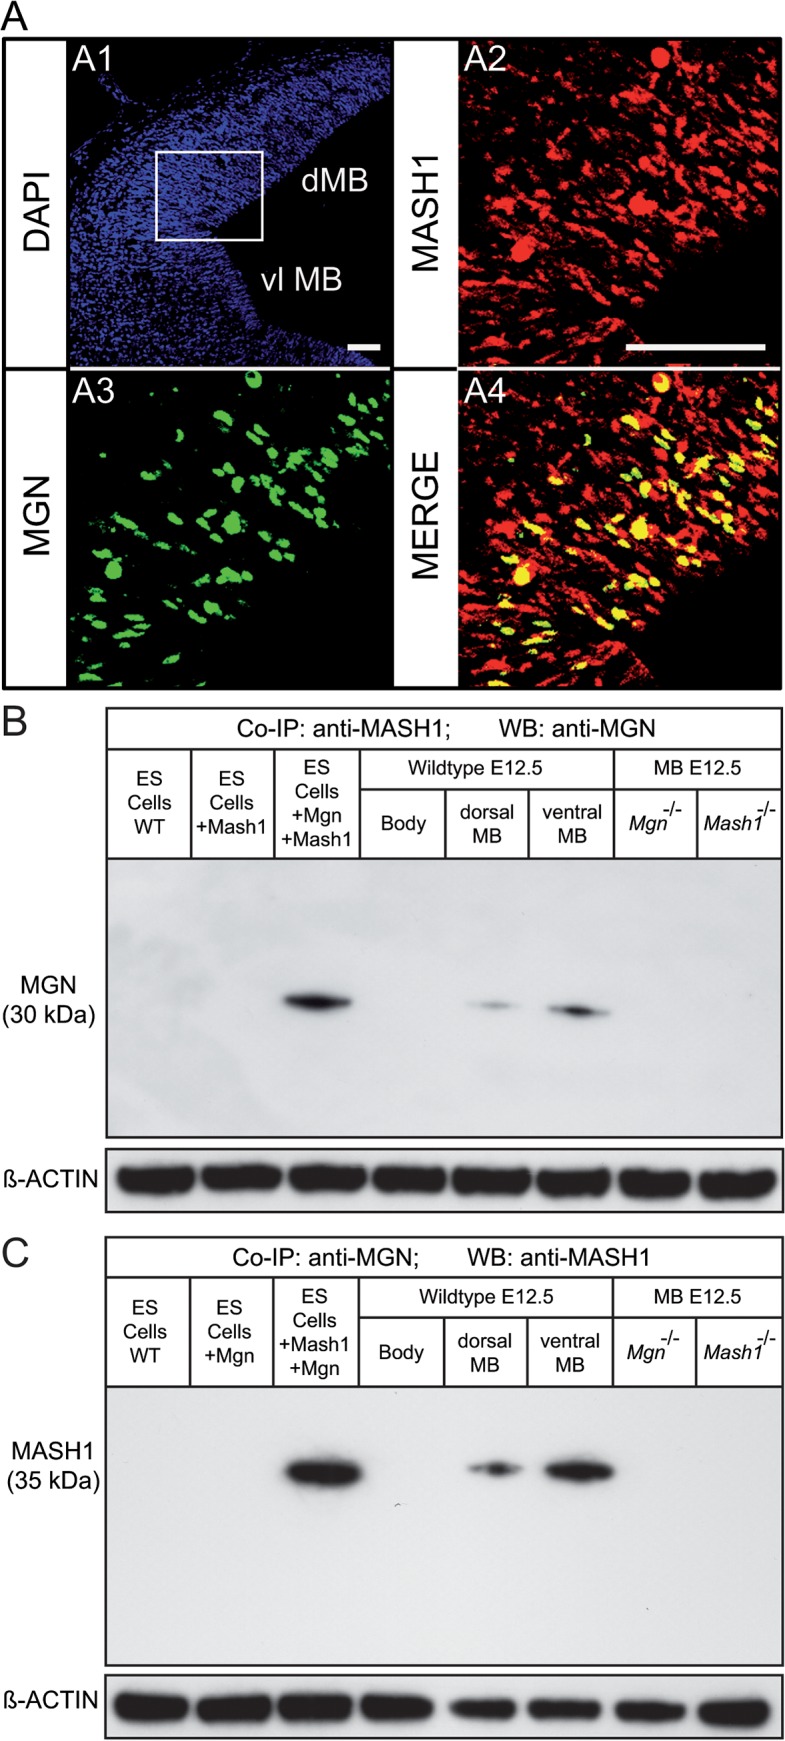
Colocalization and co-immunoprecipitation of MGN and MASH1 in mice.Immunohistochemical staining of coronal sections from E12.5 wild-type mouse embryos. (A) Representative confocal photomicrographs of immunohistochemical staining with anti-MASH1 (A2) and anti-MGN (A3) from the dMB (squared area). Nuclei stained with DAPI are shown in blue (A1). A merged picture of A2 and A3 indicating the colocalization of MASH1 and MGN is shown in A4. The MGN+ subpopulation represented approximately 50% of the total MASH1+ cells of the VZ at this stage. (B-C) MASH1 is an interaction partner of MGN in physiological conditions. Endogenous MGN was IP from the dMB and vMB of E12.5 wild-type mouse embryos with anti-MASH1 antibody and detected by western blotting with anti-MGN antibody (B) and vice versa (C). Lysates from 129SV embryonic stem cells (ES) electroporated with the indicated plasmids, the embryo body (where Mgn is not expressed) and the MB from Mgn
−/− and Mash1
−/− mutants were used as controls. Equal input and quality of the protein lysate prior to immunoprecipitation was shown by immunostaining with anti-ß-ACTIN antibody. Scale bars: 100 μm.